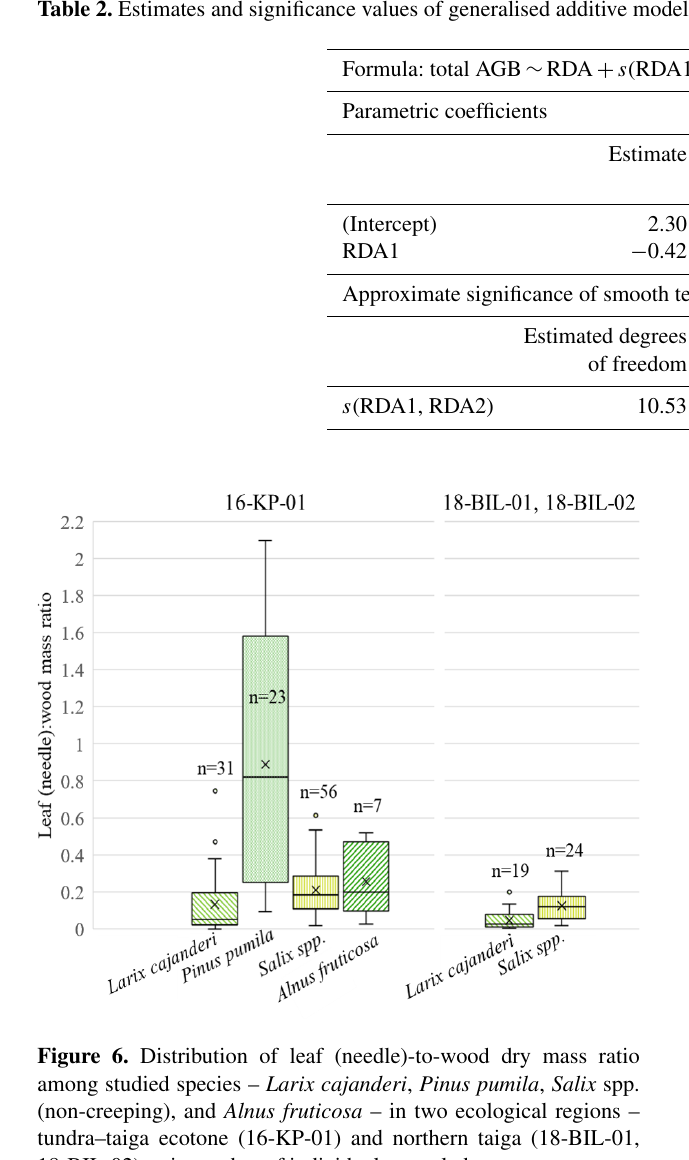
Table 2. Estimates and significance values of generalised additive model (GAM) parameters.